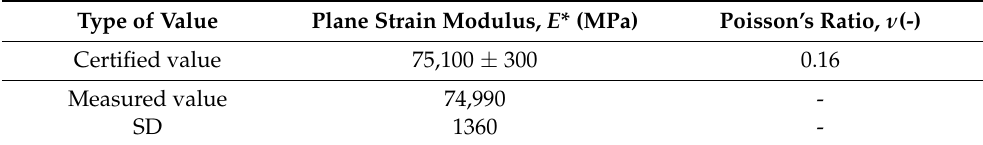
Table 1. Material properties of fused silica